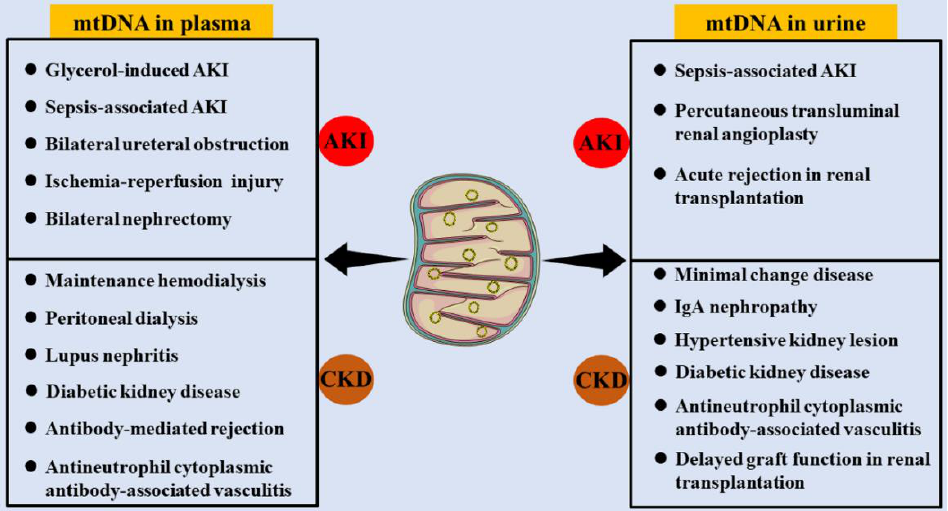
Figure 3. mtDNA distribution in kidney diseases. mtDNA can be detected in both peripheral plasma and urine of multiple kidney diseases including AKI and CKD. (AKI, acute kidney injury; CKD, chronic kidney disease; IgA, Immunoglobulin A).